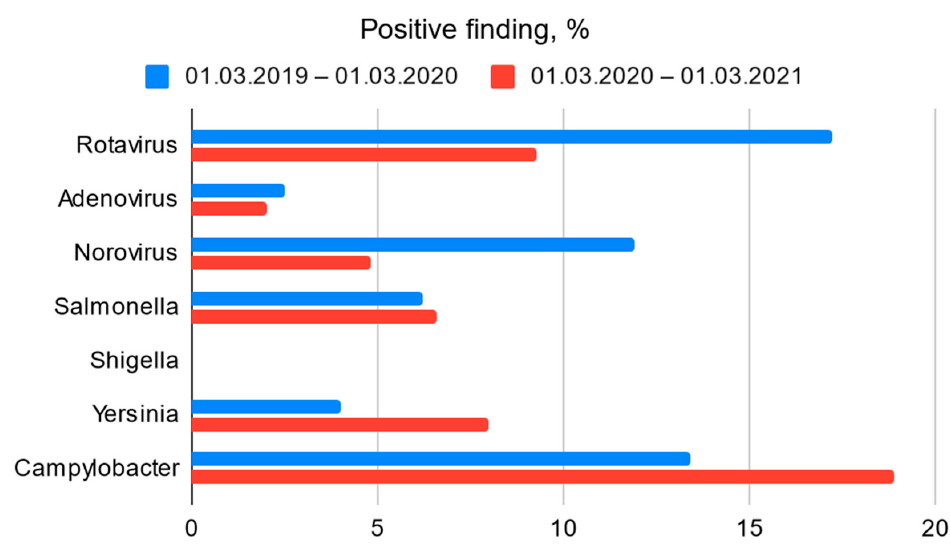
Figure 2. Bacterial and viral (Ag) positive finding among all clinical samples obtained from EAOD and Infectious Diseases department’s patients.